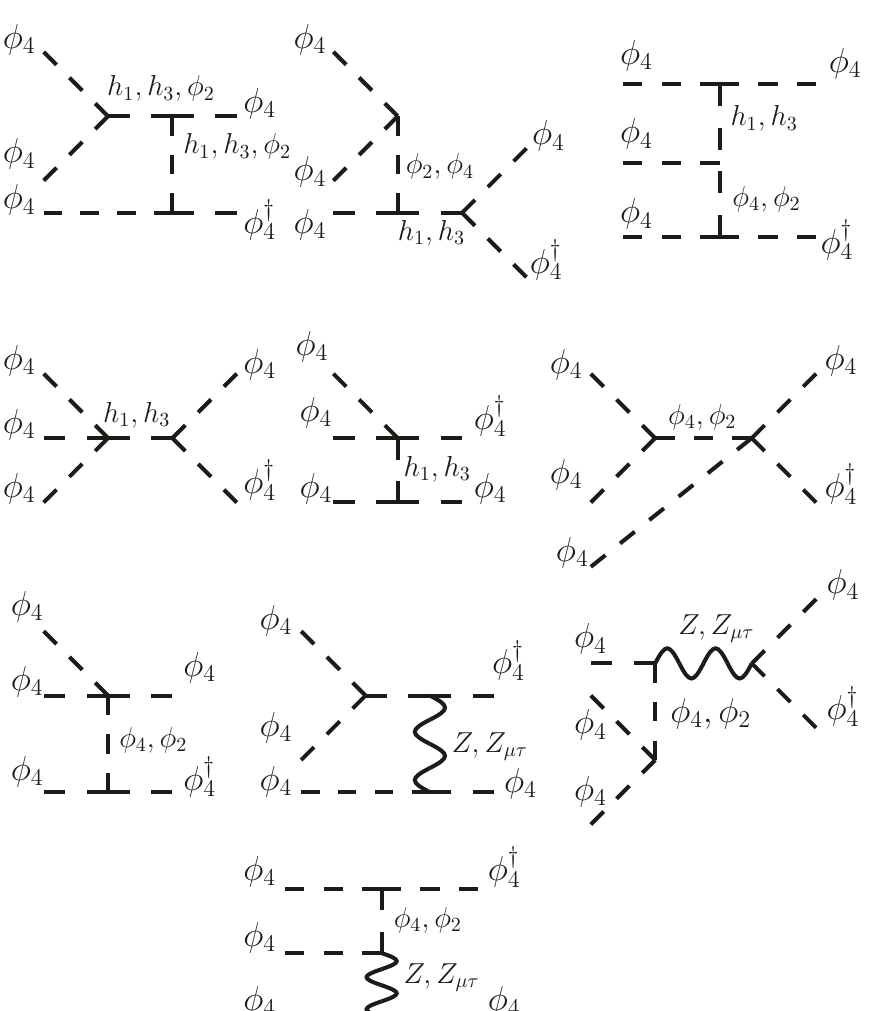
, where comoving number 4